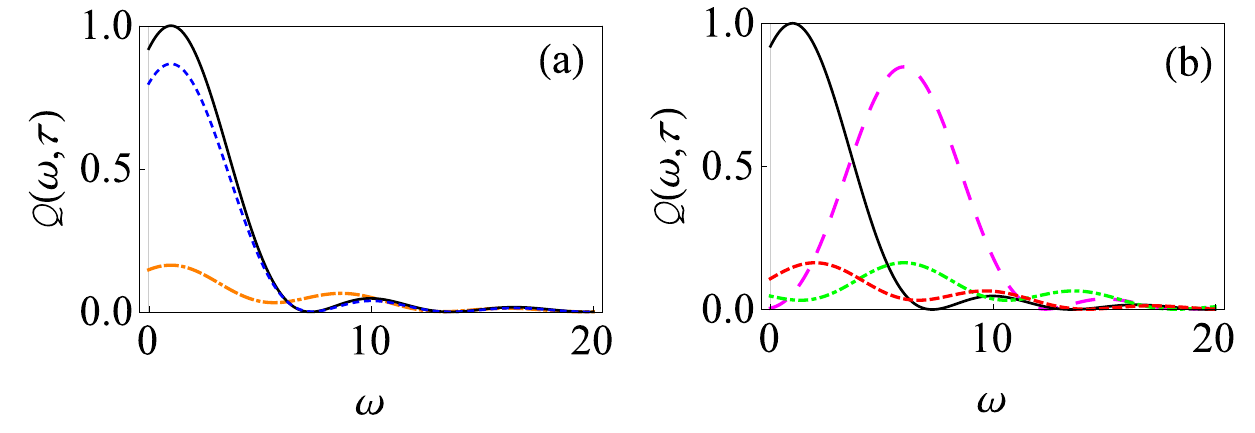
Figure 2. Filter function for the driven population decay model with the RWA. ( a ) Graph of Q (ω , τ) versus ω 0.2 1 )/χ and γ( t ) 0 with χ ( e − χ t ε 0 t , β( t ) in the presence of time-dependent driving fields: α( t ) = = − − = = 5 (dot-dashed, orange curve), α( t ) 0 with υ υ t and γ( t ) ε 0 t , β( t ) ε 0 t , (dashed, blue curve), α( t ) = = = = = 1 . ( b ) Here α( t ) 0 and γ( t ) 0 (solid, black curve). We have used τ β( t ) υ t and γ( t ) ξ t , ε 0 t , β( t ) = = = = = = 5 and ξ 1 and ξ 5 and ξ 1 (dashed, red curve), υ 5 (long-dashed, magenta curve), and υ 5 with υ = = = = = = 0 and γ( t ) 0 . We have again used ε 0 t , β( t ) (dot-dashed, green curve). The solid black curve shows α( t ) = = = 1 . τ =